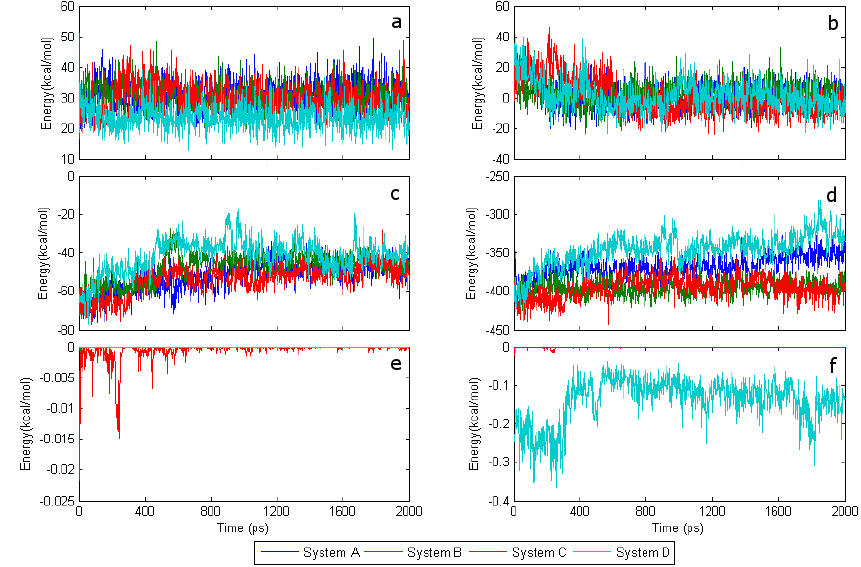
Figure 3 . Energy trends during 2-ns MD simulation. (a) Potential energy of isoalloxazine; (b) potential energy of FAD; (c) interaction energy between isoalloxazine and apo-GOx; (d) interaction energy between FAD and apo-GOx; (e) interaction energy between isoalloxazine and SWCNT; (f) interaction energy between FAD and